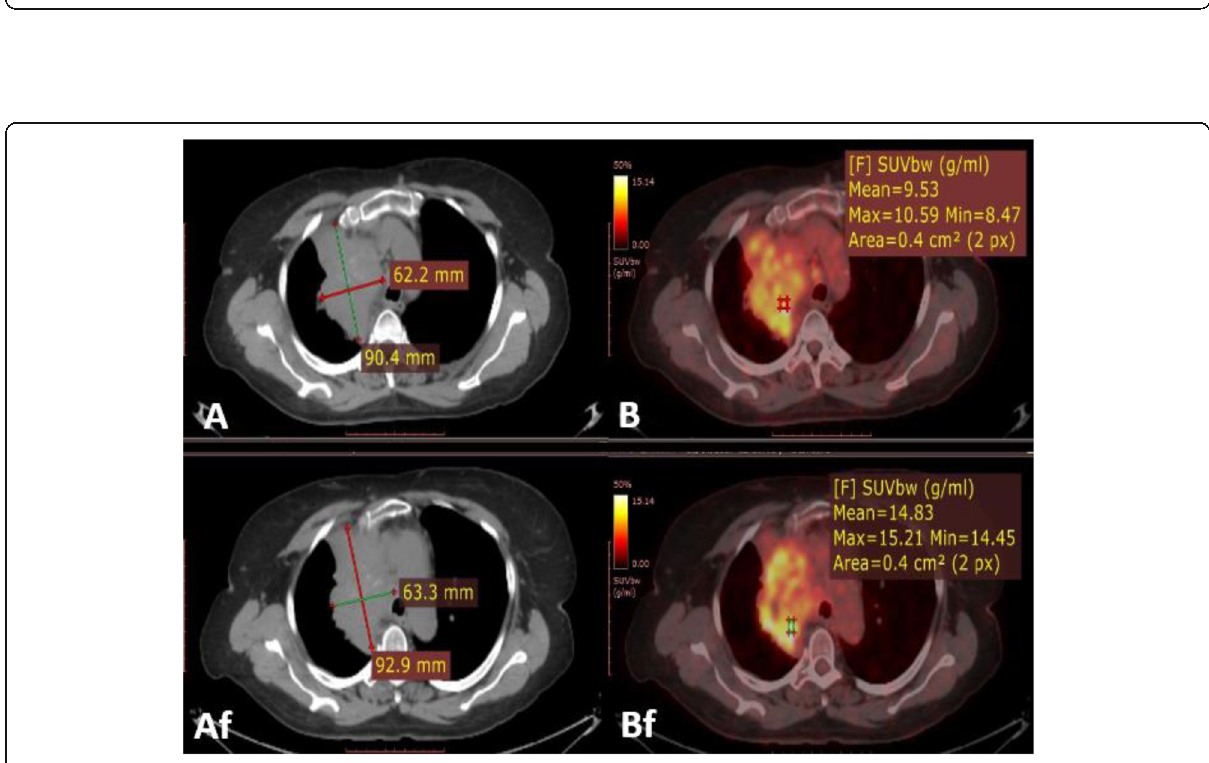
Fig. 13 A female patient 70 years old diagnosed to have NSCLC received chemotherapy and radiotherapy. Baseline study ( A and B ) showed the mass lesion = 90 × 62 mm in average with SUV uptake = 9.5. On follow-up after 3 months ( Af and Bf ) showed almost no change in the size of the mass by CT = 92 × 63 mm in average interpreted as stable disease by RECIST criteria while in PET/CT, the SUV increased to be 14.8 instead of 2.9 leading to change in opinion to be progressive disease response by PERCIST criteria instead of stable disease by RECIST